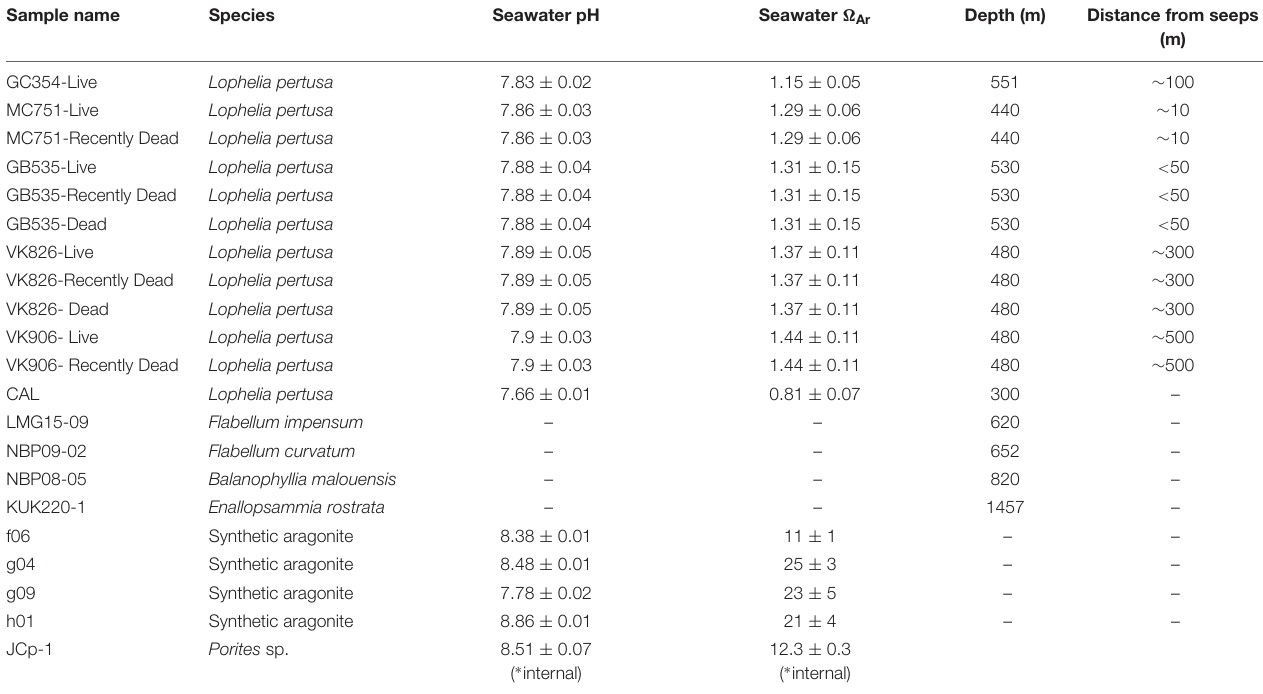
TABLE 1 | Corals, synthetic aragonites, and aragonite reference samples analyzed in this